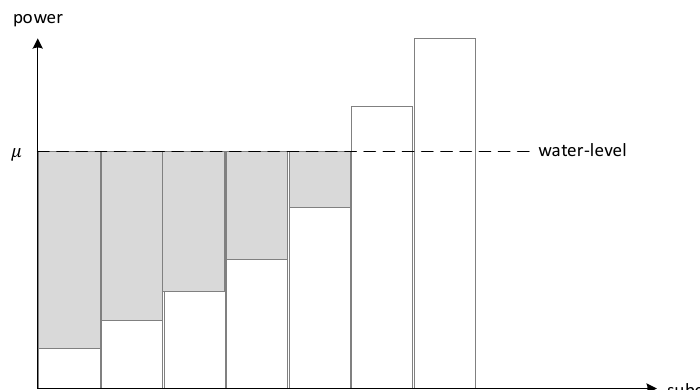
Figure 4. Classical water-filling power allocation.